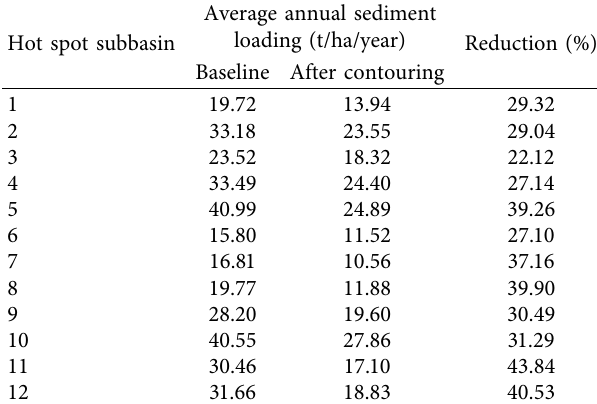
Table 15: Summary of sediment reduction with contouring simulation.